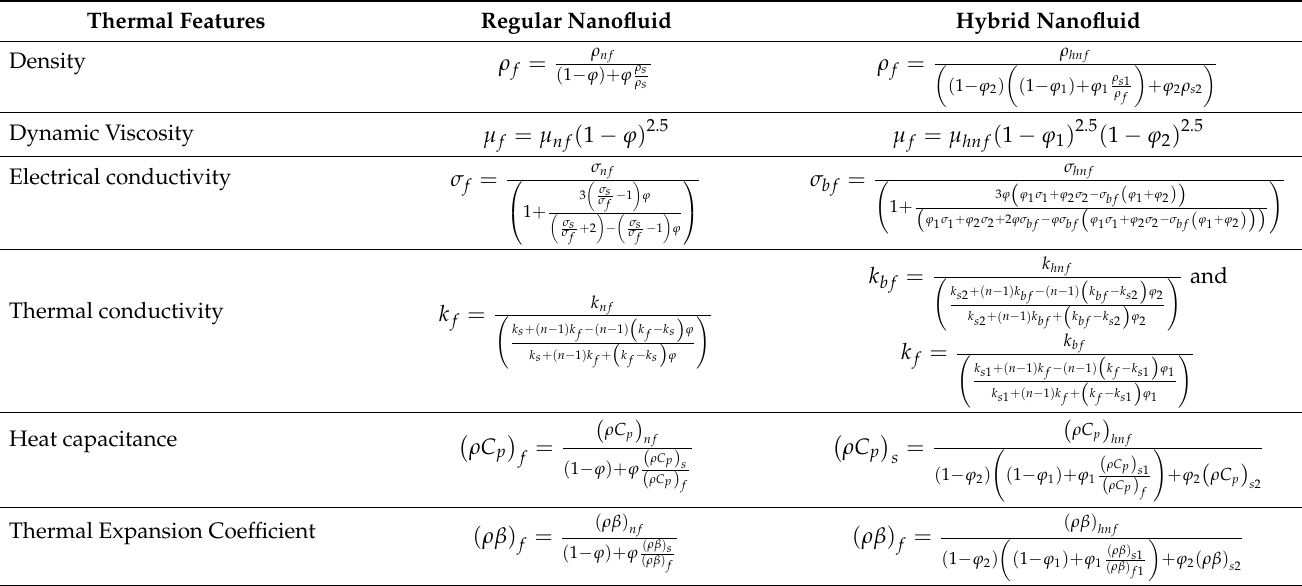
Table 1. The quantities of nanofluids thermophysical